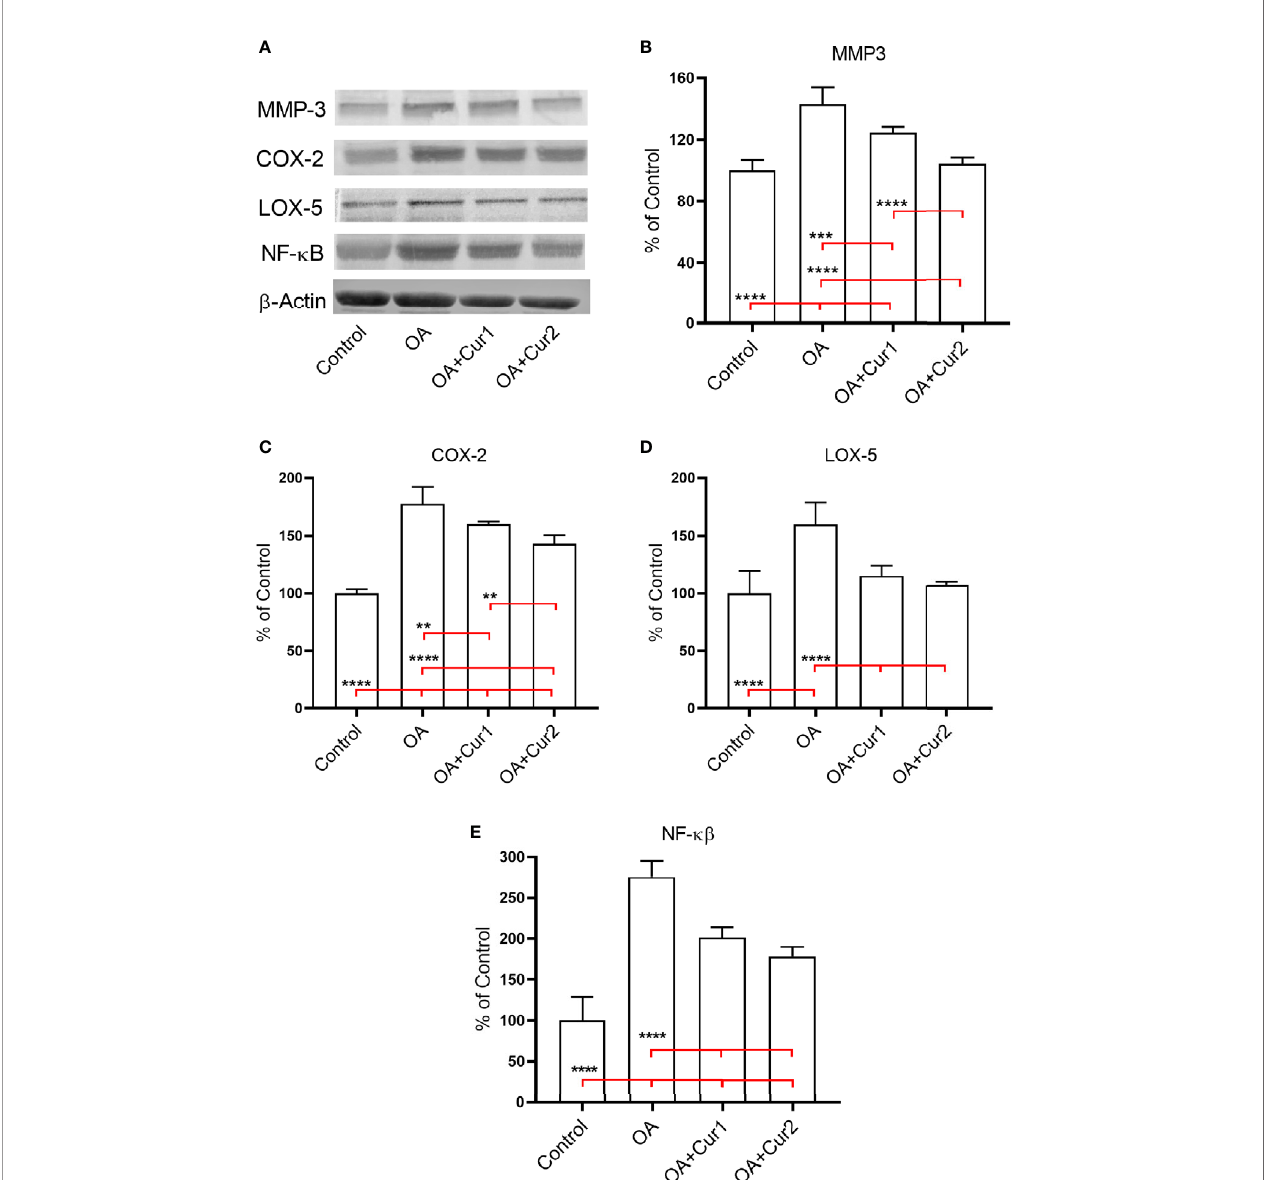
FIGURE 6 | Effects of Next Generation Ultrasol Curcumin (NGUC) supplementation on protein expressions of MMP-3, COX-2, 5-LOX, and NF k B in rats with monosodium iodoacetate (MIA)-induced OA. (A) Representative protein expressions of MMP-3, COX-2, 5-LOX, and NF k B levels in synovial tissue of rats. b -actin was referenced to ensure equal protein loading. Graphs demonstrate densitometric analysis of the western blots for (B) MMP-3, (C) COX-2, (D) 5-LOX, and (E) NF k B. Data represent percent of the control values. Blots were repeated at least three times. Statistical differences among the groups were determined by one- way ANOVA followed by a post-hoc Tukey test; ** p < 0.01, *** p < 0.001, **** p < 0.0001). NGUC, next generation ultrasol curcumin; OA, osteoarthritis; OA+Cur 1, 100 mg/kg of NGUC; OA+Cur 2, 200 mg/kg of NGUC; MMP-3, matrix metalloproteinase-3; COX-2, cyclooxygenase-2; 5-LOX, 5-lipoxygenase; NF k B, Nuclear Factor kappa